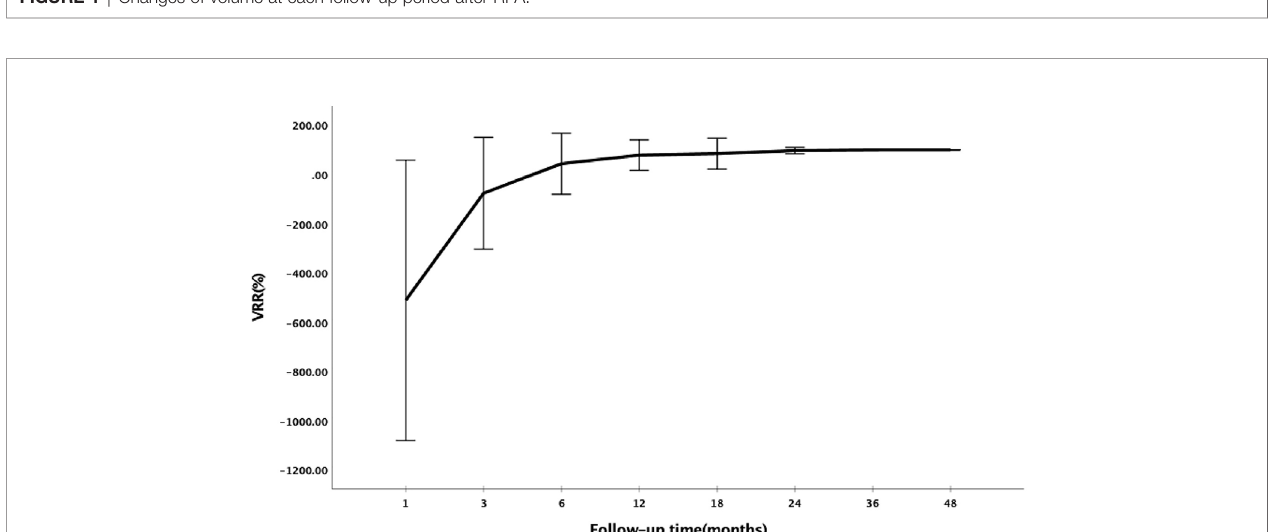
FIGURE 1 | Changes of volume at each follow-up period after RFA.